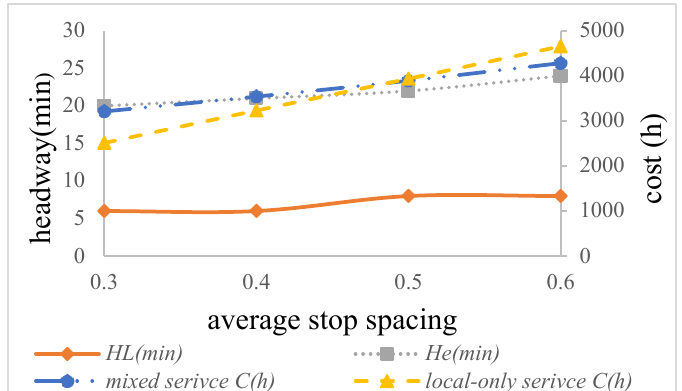
Figure 6. The cost variation in the mixed service and the local-only service with changes to the average stop spacing.